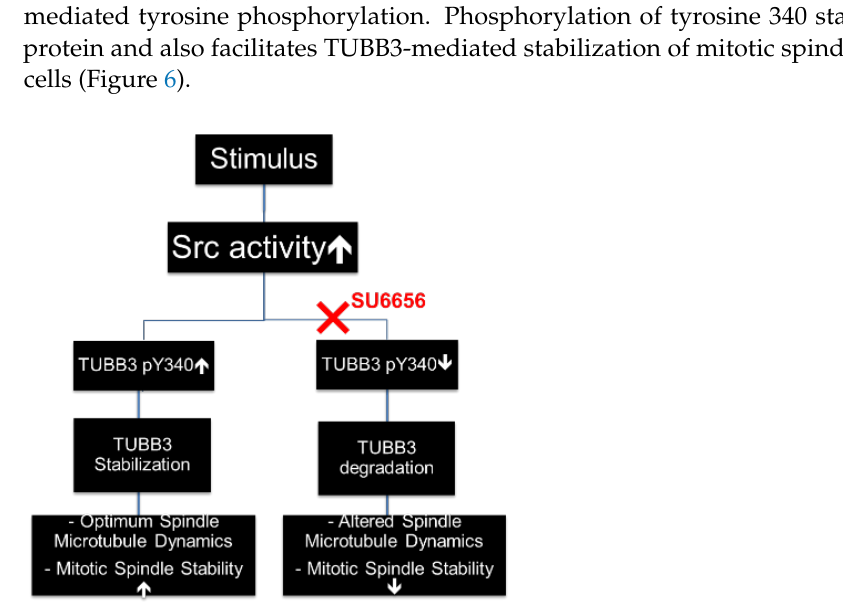
Figure 6. Working model of regulation of TUBB3 by SRC kinase. Upstream stimuli activate SRC kinase, resulting in an increase of TUBB3 phosphorylation at Y340. This increased Y340 phosphorylation results in enhanced TUBB3 stability, which leads to mitotic spindle stability, TUBB3-mediated cell survival, and decreased effectiveness of DTX treatment. However, pharmacological inhibition of SRC kinase, such as with SU6656, decreases TUBB3 Y340 phosphorylation and reduces stability of TUBB3, which in turn leads to compromised mitotic spindle integrity in dividing cells.